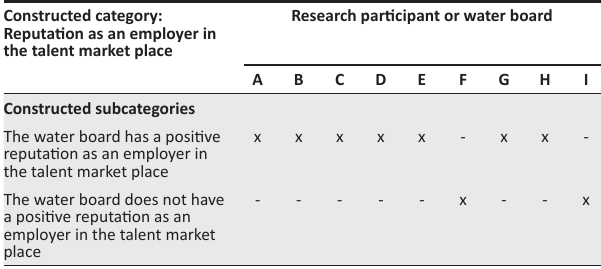
Research participant or water